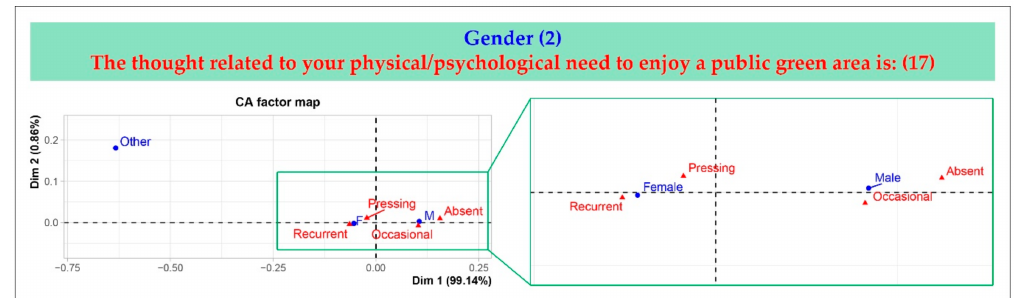
Figure 5. CA results for the relationship between the respondent characteristics (gender) and their public green area perceptions during the social distancing period (questions 2–17). On the right of the figure there is an expansion of the CA factor map.